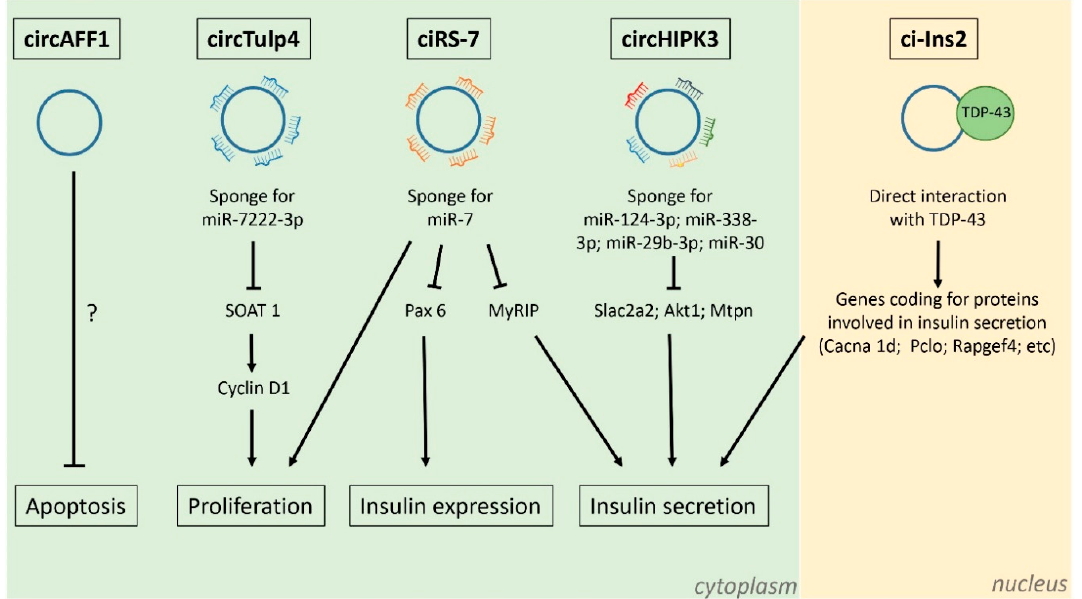
Figure 3. Functions of circRNAs expressed in pancreatic β -cells. CircTulp4 [70], circAFF1, ciRS-7, circHIPK3 [33], and ci-Ins2 [73] are among the most abundant circRNAs expressed in pancreatic β -cells. CircTulp4, ciRS-7, and circHIPK3 are exonic circRNAs mainly localized in the cytoplasm and act as microRNA sponges. They affect the expression of different proteins involved in β -cell proliferation, insulin biosynthesis, and insulin secretion. CircAFF1 is also exonic and inhibits β -cell apoptosis through an unknown mechanism. Ci-Ins2 is an intronic circRNA localized mainly in the nucleus and interacts with the RNA-binding protein TDP-43. Ci-Ins2/TDP-43 interaction promotes the expression of many genes coding for proteins involved in insulin secretion. CircTulp4, ciRS-7, circHIPK3, and ci-Ins2 expression is downregulated in islets from db/db mice. Moreover, the level of ci-Ins2 is also decreased in the islets obtained from T2D patients.